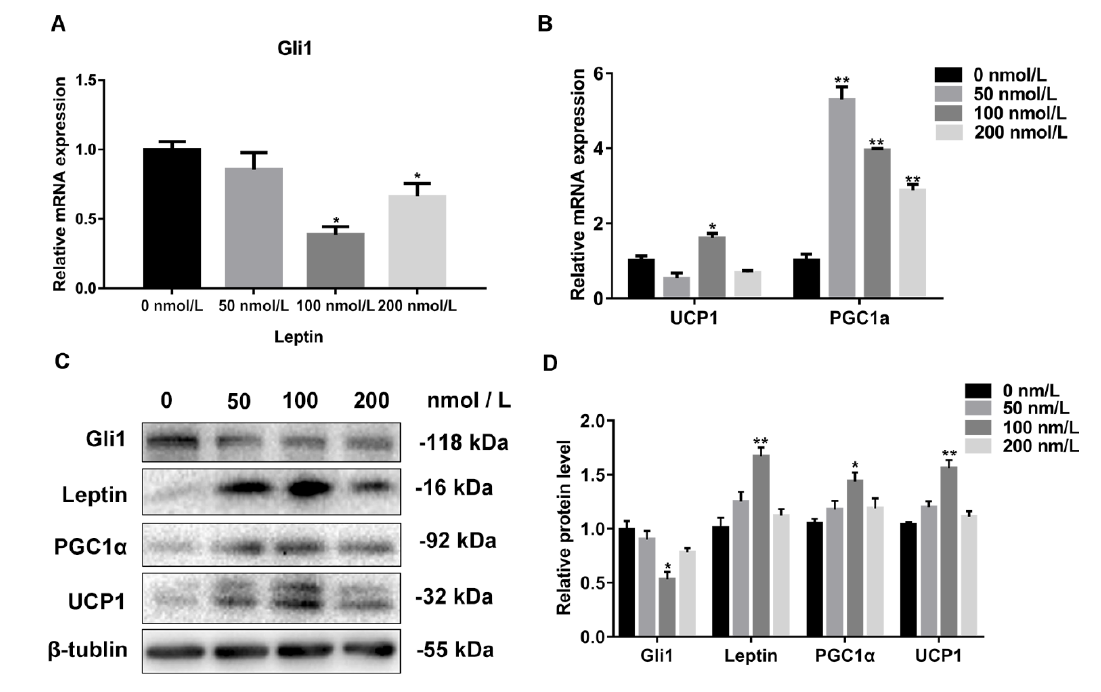
Figure 5. The expression level of Gli1 is negatively correlated with the concentration of leptin. ( A ) RT-qPCR was used to detect the key transcription factor Gli1 of the Hh signaling pathway. ( B ) RT-qPCR was used to detect the white adipose thermogenic related genes. ( C ) Western blotting was used to detect the expression of genes associated with the Hh signaling pathway, and thermogenic relative genes. ( D ) The resulting quantity protein level. Data are expressed as the means ± SD of three independent experiments. *, p < 0.05; **, p < 0.01.